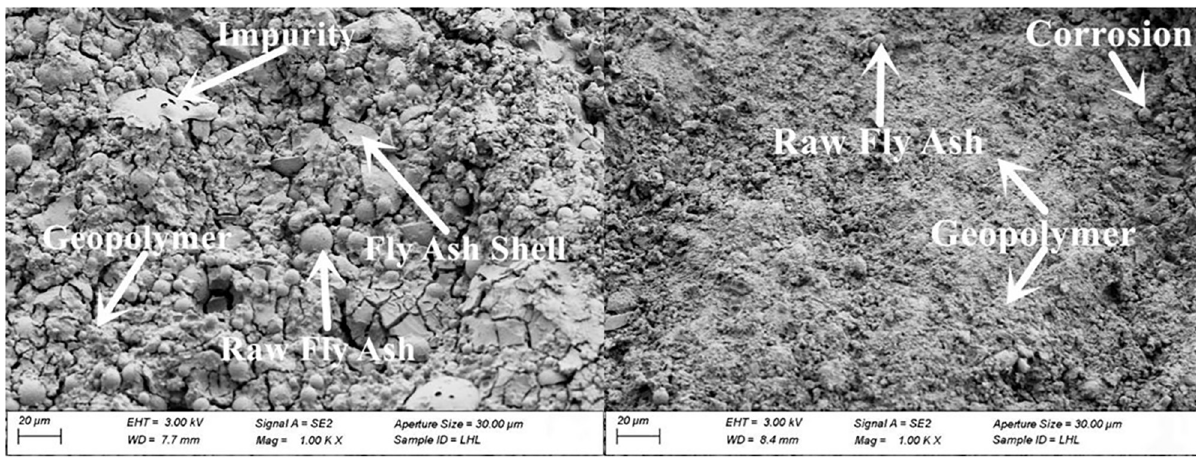
Fig 13. Microscopy analysis of FG2 at 28 d.